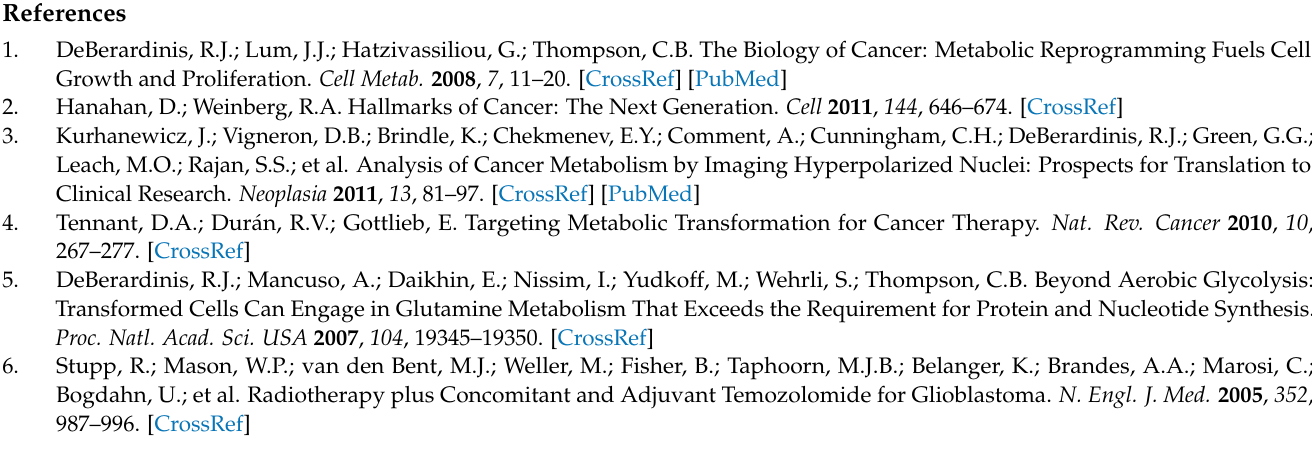
column in positive ionization mode. Table S7: Panel of compounds representing differences between high-grade- (stage III and IV) and low-grade-malignancy gliomas (stage I and II) selected by LASSO using a PFP column in positive ionization mode. Table S8: Compounds differentiating high-grade- and low-grade-malignancy gliomas based on ANOVA using a PFP column in positive ionization mode. Table S9: Panel of compounds representing differences between patient with and without isocitrate dehydrogenase mutations selected by LASSO using a PFP column in positive ionization mode. Table S10: Comparison of masses selected by lasso in the analysis of patients with/without IDH using different columns and ionization modes. Table S11: Statistical performance of PLS-DA model for patients with and without IDH mutation. Data for PFP column acquired in ESI- mode; data for HILIC column acquired in ESI+ and ESI- modes. Table S12: Compounds differentiating patients with and without isocitrate dehydrogenase mutations based on ANOVA using a PFP column in positive ionization mode. Table S13: Panel of compounds representing differences between patients with and without 1p19q codeletion selected via the LASSO method using a PFP column in positive ionization mode. Table S14: Comparison of masses selected via LASSO for the analysis of patients with/without codeletion using different columns and ionization modes. Table S15: Statistical perfor- mance of PLS-DA for patients with and without 1p19q codeletion. Data for PFP column acquired in ESI- mode; data for HILIC column acquired in ESI+ and ESI- mode. Table S16: Compounds differentiating patients with and without 1p19q codeletion selected via ANOVA using a PFP column in positive ionization